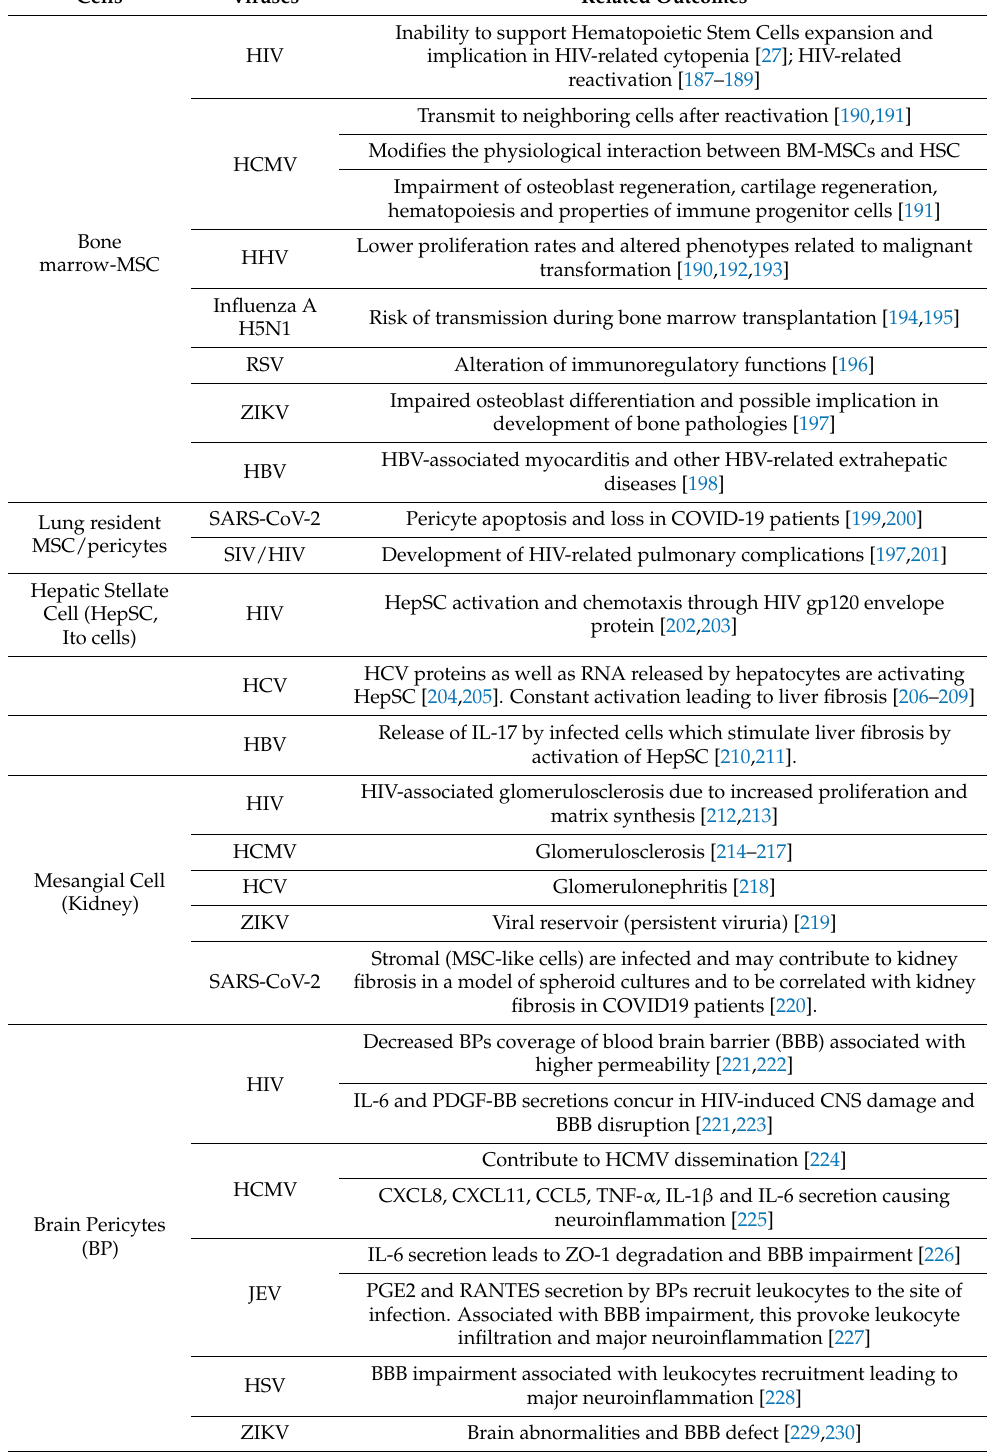
Table 3. Examples of viruses targeting MSCs and related